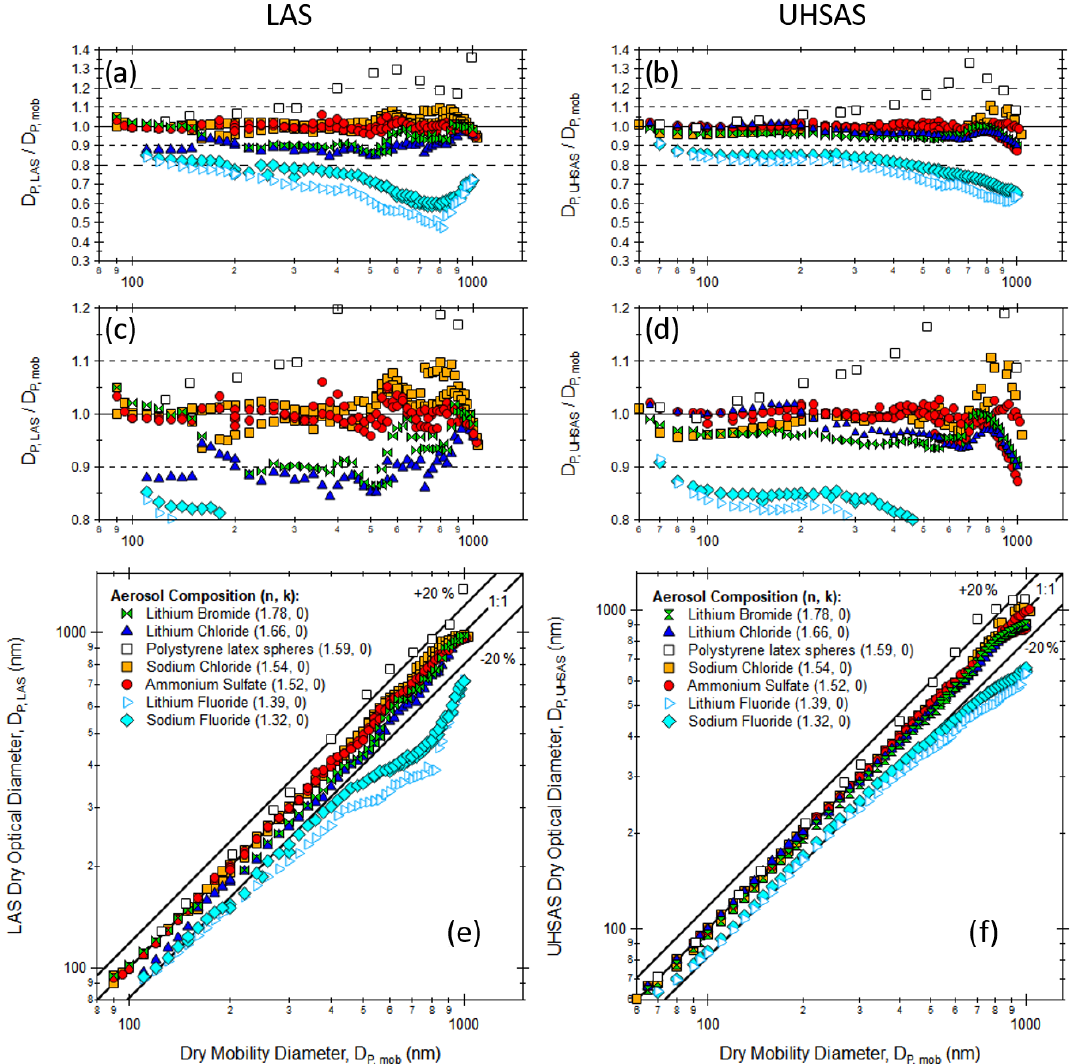
Figure 5. Comparison of optically sized particle diameter as measured by the LAS (a, c, e) and the UHSAS (b, d, f) to the DMA-classified mobility diameter for the non-light-absorbing aerosol species listed in Table 1. Both optical sizers were calibrated to ammonium sulfate. Panels (a) – (d) show the ratio of the optical measurements to the mobility measurements, while the bottommost panels show the data plotted on a 1:1 line ( ± 20% indicated). Panels (a) – (d) show the same information with panels (c) and (d) zoomed in to show additional details. Particles were dried to less than 20% RH with a silica gel diffusion dryer. Raw data for this figure are available in the